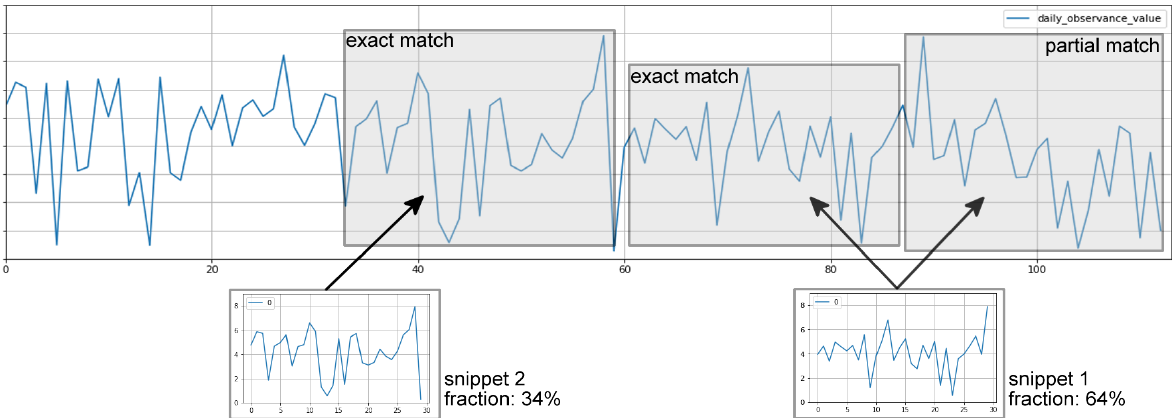
Figure 4. Example of a time series with two detected snippets along with the main matches of each one. By exact match, we mean the snippet has maximum MPdist similarity to a subsequence in the original time series; a partial match means the similarity is high but not maximal.